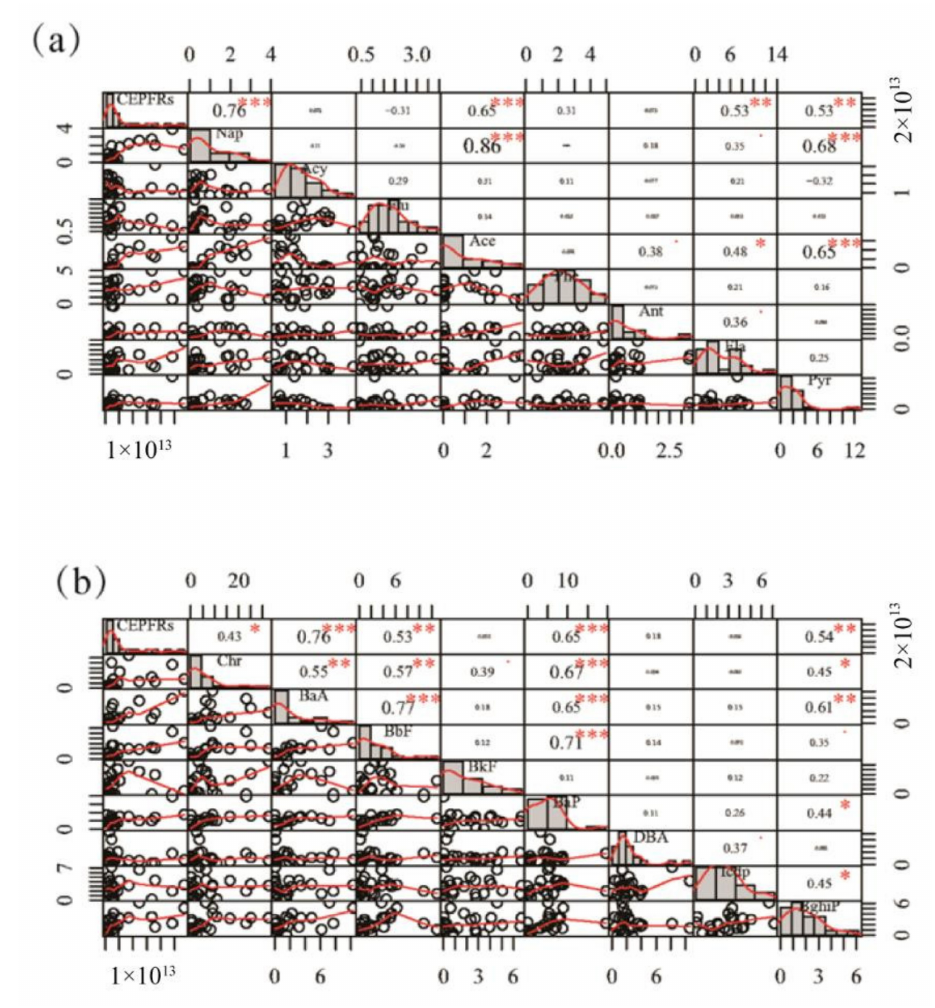
Figure 3. Pearson’s correlation matrices for atmospheric concentrations of environmentally persistent free radicals and eight monomers of PAHs (Nap, Acy, Flu, Ace, Phe, Ant, Fla, and Pyr) ( a ), and a further eight monomers of PAHs (Chr, BaA, BbF, BkF, BaP, DBA, Icdp, and BghiP) ( b